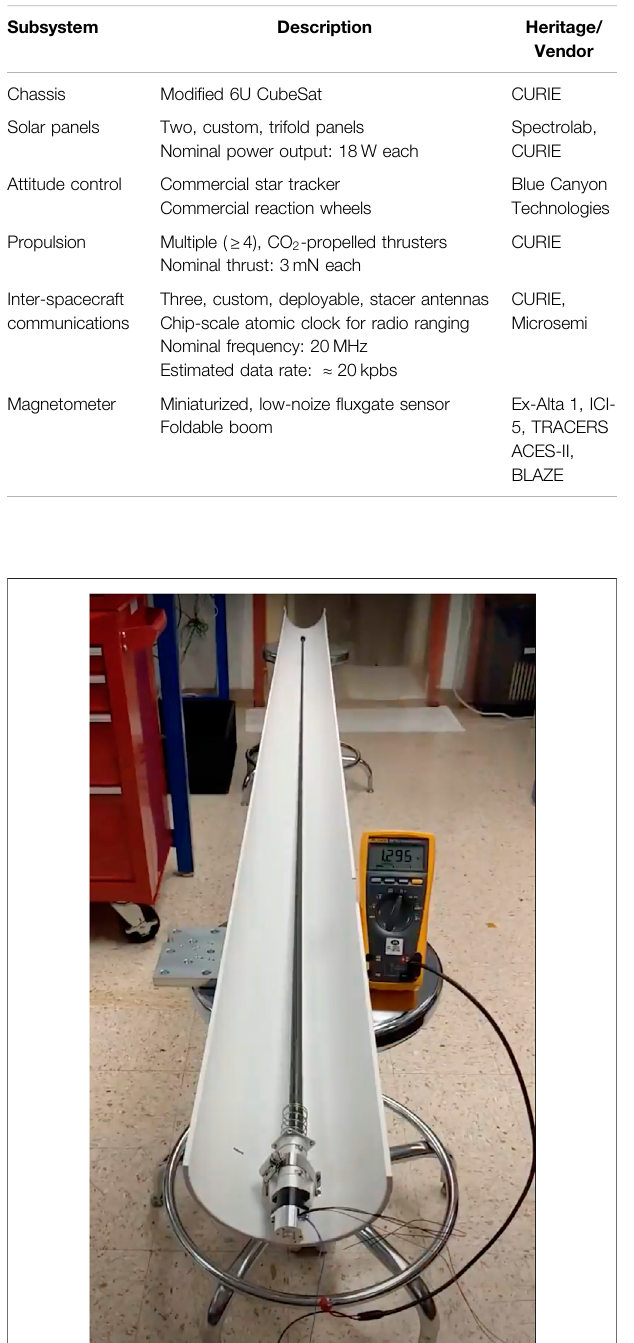
TABLE 3 | Summary of design for probe spacecraft.